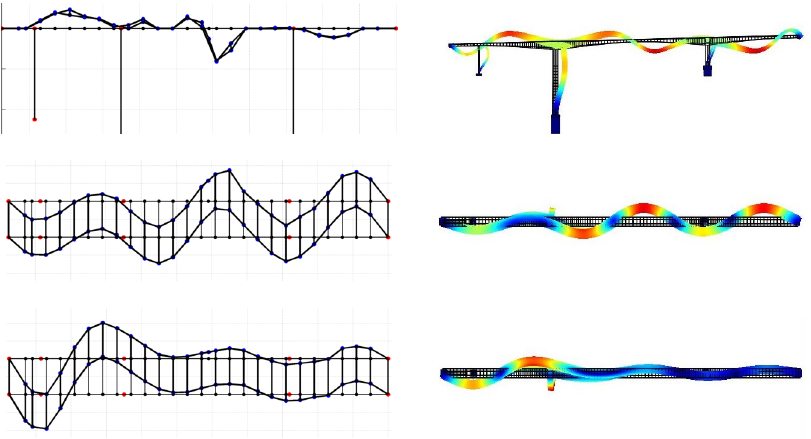
Figure A4. Comparison between the experimentally identified (left column) and nominal FE model predicted (right column) mode shapes of the Metsovo bridge. Modes